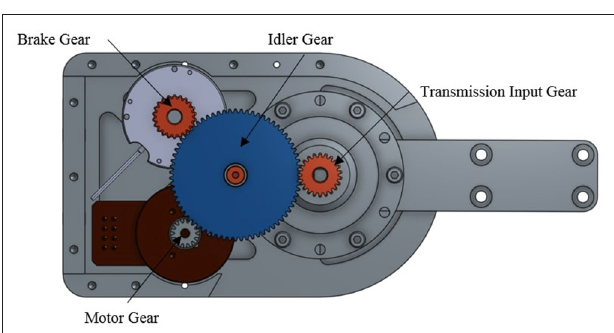
FIGURE 2 | Input transmission.